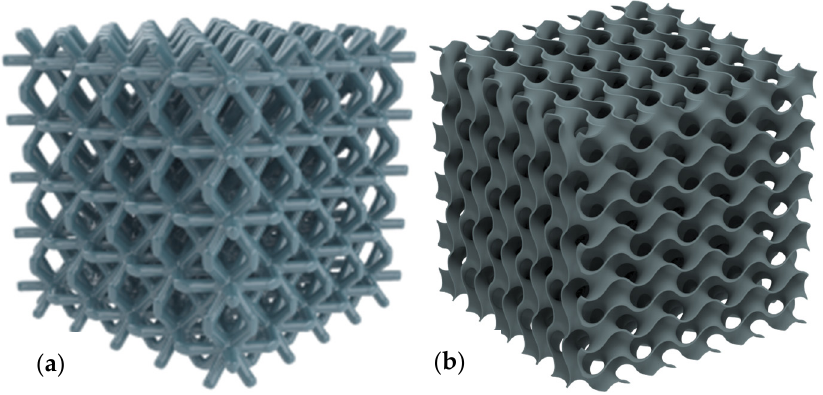
Figure 24. Typical additive manufactured representations showing the computational model ( a ) a strut-based lattice structure, and ( b ) a surface-based lattice structure.